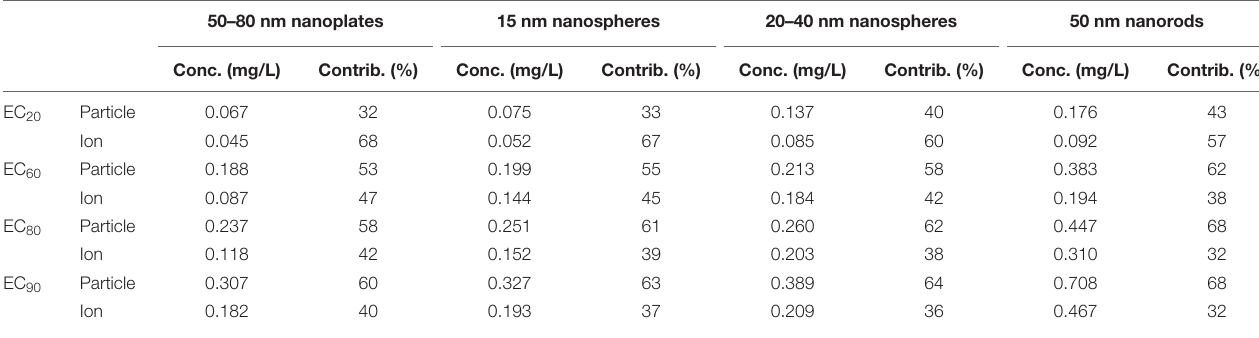
TABLE 3 | Relative contribution of particles and shedding ions of AgNPs to toxicity at different effect levels of nanoparticle